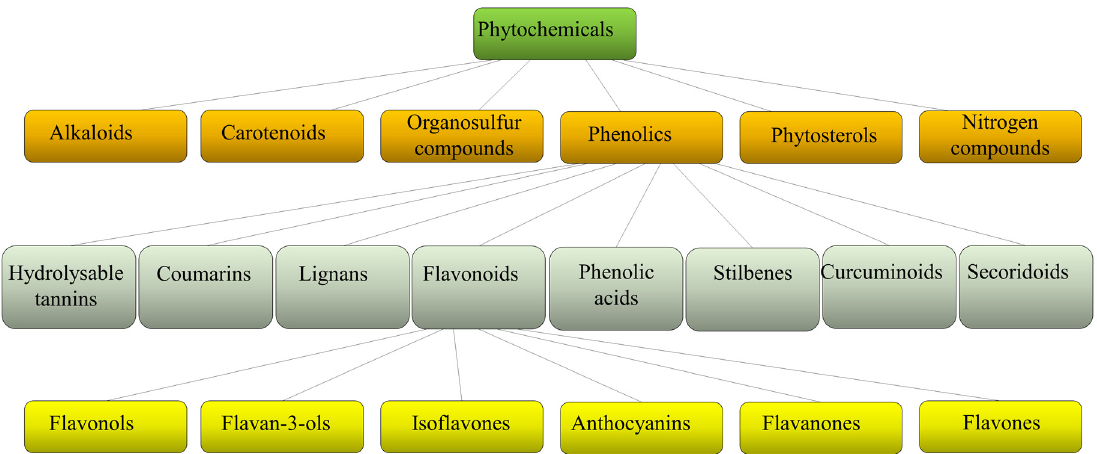
Figure 1. Schematic classification of phytochemicals, with sub-classification of phenolics and flavo- noids.